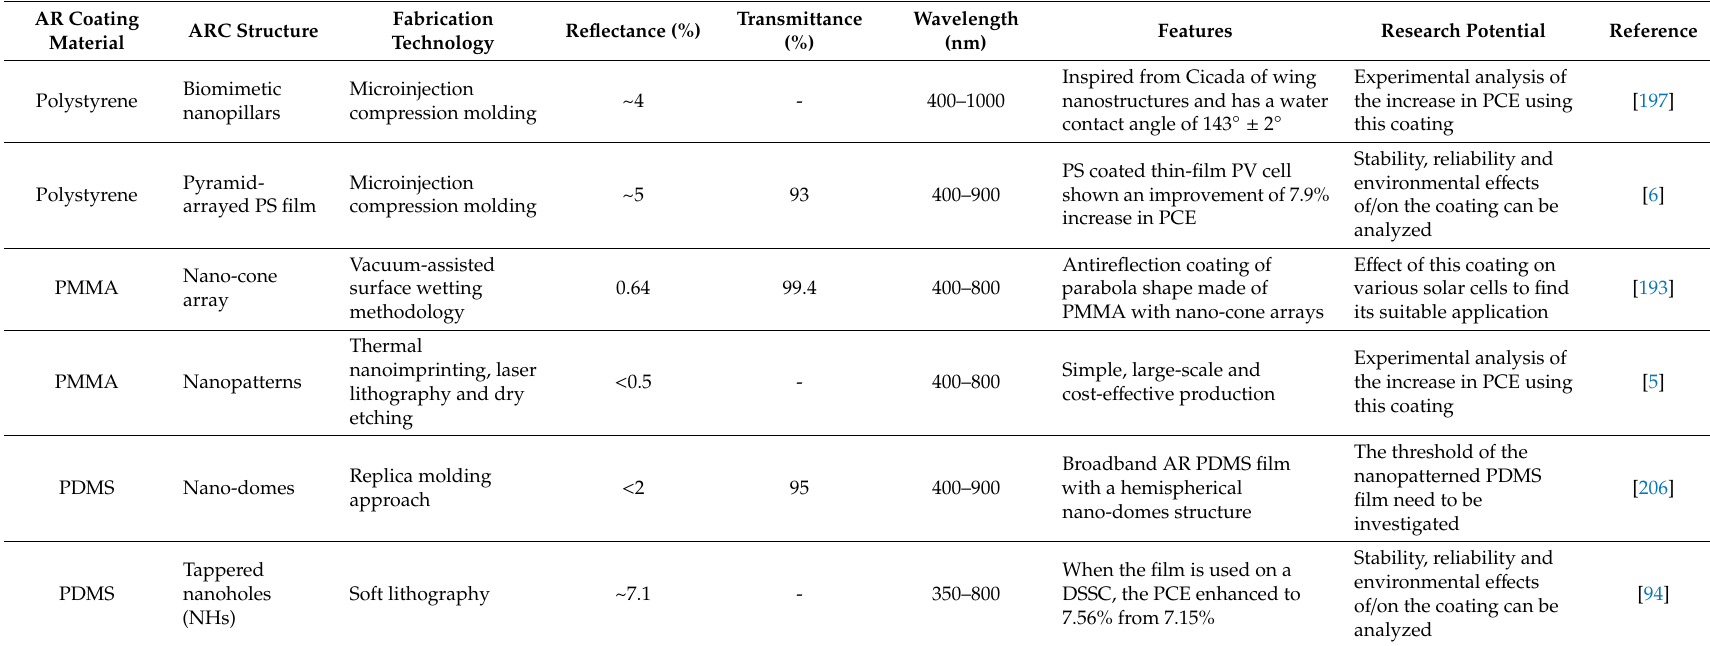
Table 5. Polymer based antireflection